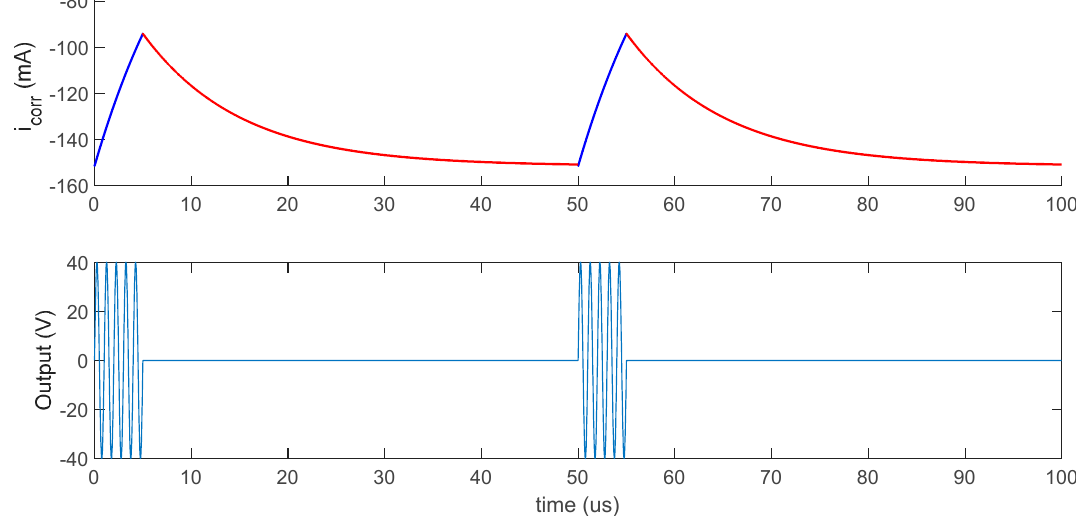
Figure 4. Correction current ( top ) and output voltage ( bottom ) during 2 PRIs of periods of 50 µs each. The current starts from i pre = − 150 mA and decays with a 10 µs constant (blue curve) during the burst transmission. At the end of the burst, the current recovers the initial value.